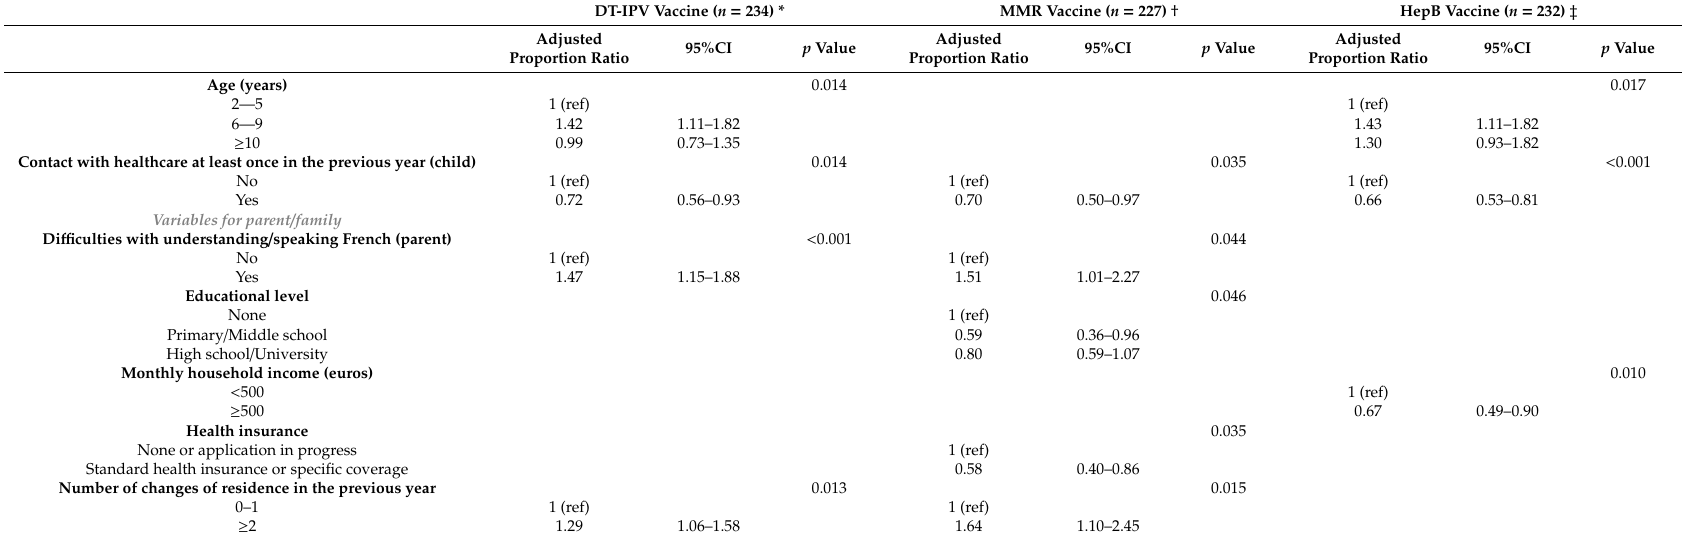
Table 4. Factors associated with insu ffi ciently immunized children for DT-IPV, MMR and HepB based on a multivariate robust Poisson model among children not born in